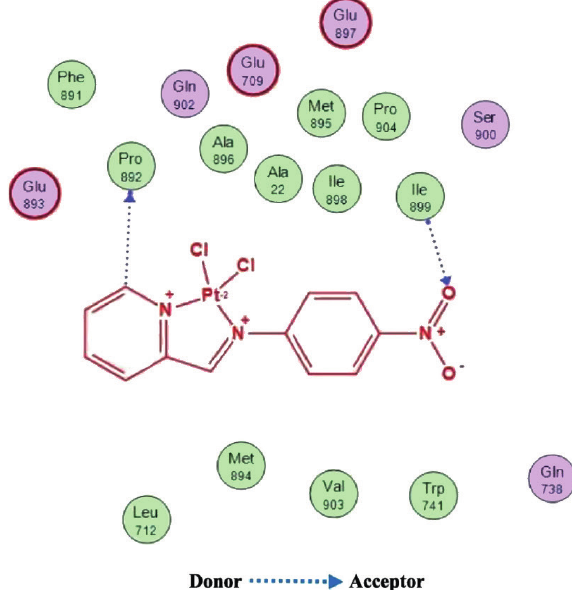
Figure 3 Methods of binding a mononuclear complex with